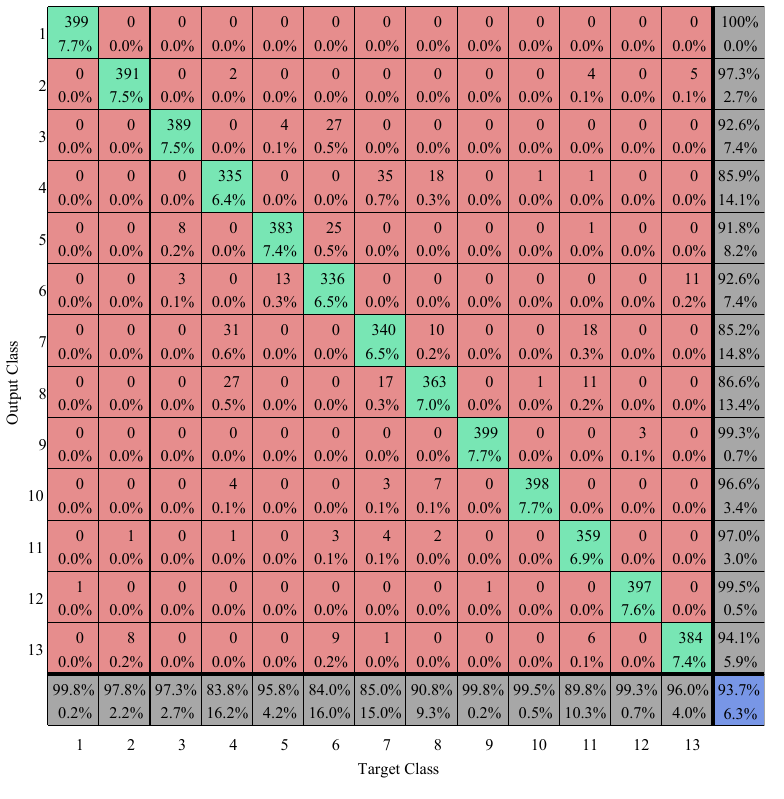
Figure 25. Confusion matrix comparison on train area (values are given in percent) The overall accuracy is